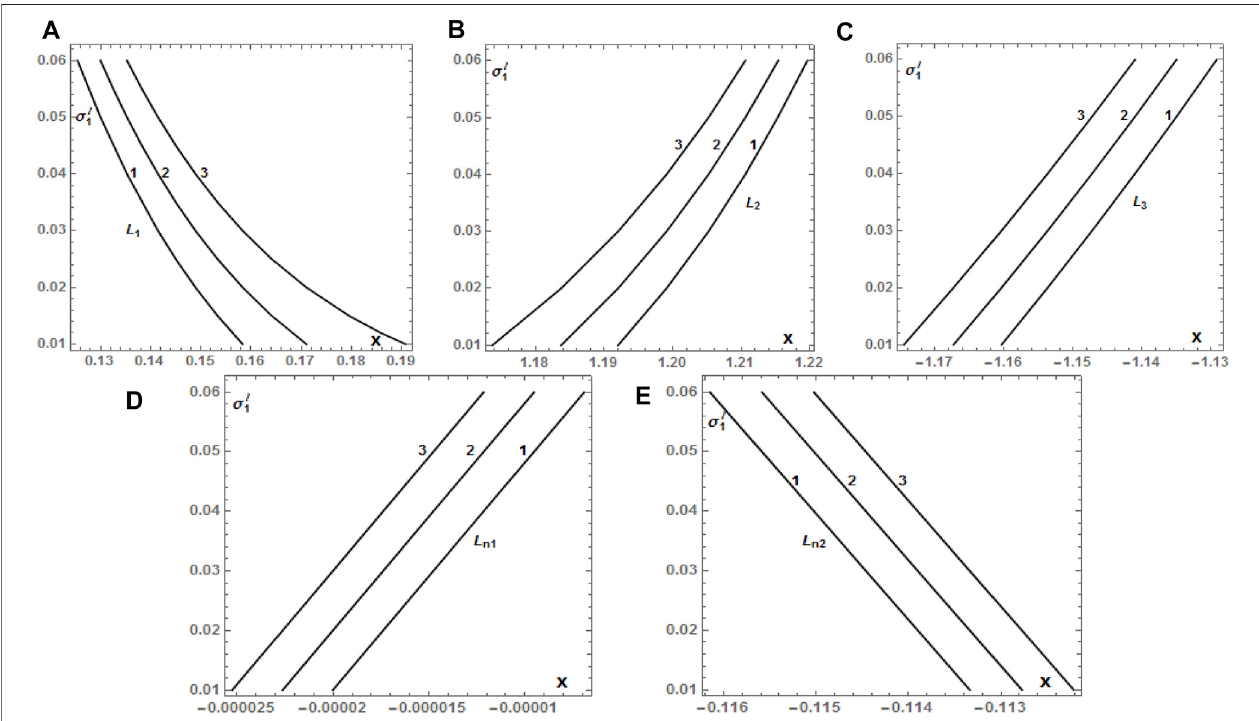
FIGURE 13 | (A – E) Positions of the collinear equilibrium points L i , i = 1, 2, 3, L nj , j = 1, 2, of the HD155876 system, as a function of σ 1 ′ , which varies in the interval (0.01,0.06)for fi xedvaluesof σ 2 ′ equalto0.02(1),0.04(2),and0.06(3),respectively.Theradiationpressure,oblateness,massofthedisc,andtriaxialityparametersofthe bigger primary are kept as constants as in the previous case (Table 10) . The numbering of equilibrium points is according to the diagram shown in Figure